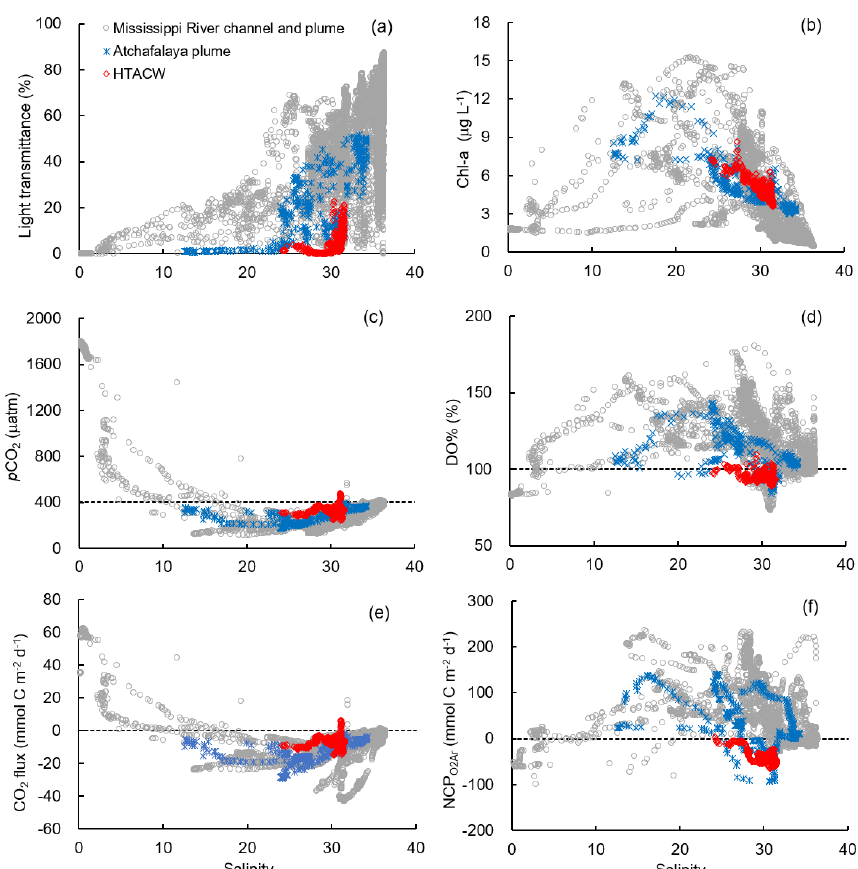
Figure 6. The distribution of (a) light transmittance, (b) Chl a , (c) p CO 2 , (d) DO%, (e) CO 2 flux, and (f) NCP O gradient in different sub-regions. The dash lines in (c) to (f) are the atmospheric p CO 2 (405µatm), DO% of 100%, zero CO 2 flux, and zero NCP O , 2 Ar